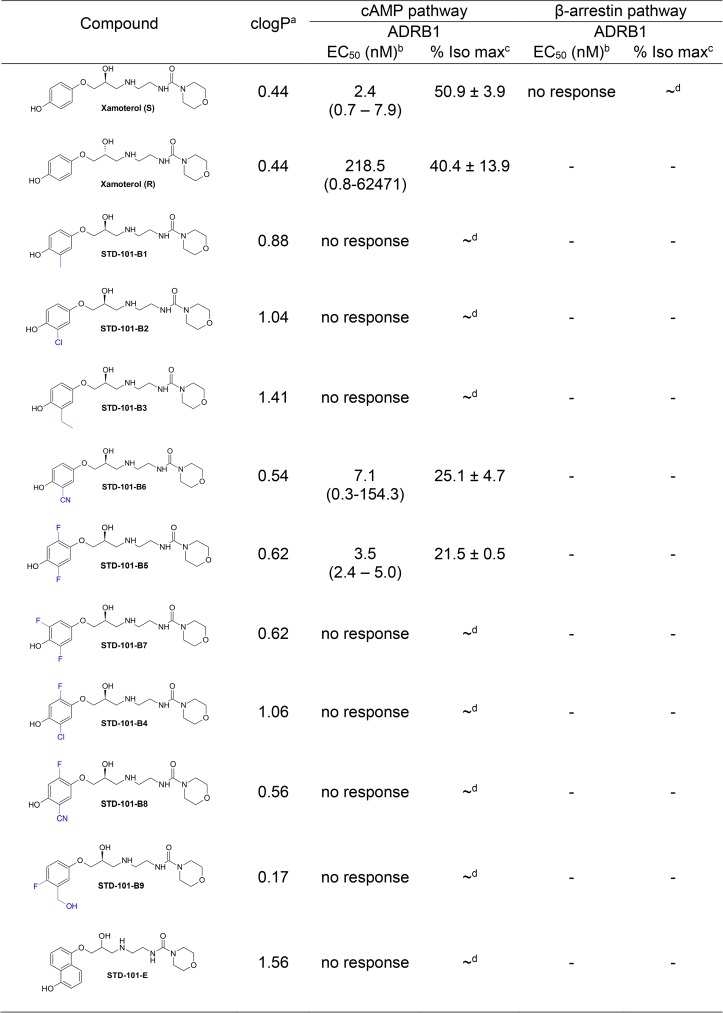
Effects of structural modifications of the phenolic OH moiety of xamoterol on the cAMP pathway mediated by ADRB1.clogPa, Calculated with ChemDraw Pro Version 16.0 (PerkinElmer Health Sciences, CT; EC50 (nM)b, Geometrical mean of EC50 values from at least two independent experiments; % Iso maxc, Percent efficacy compared to the maximum response achieved with isoproterenol; ~d, Could not be determined.